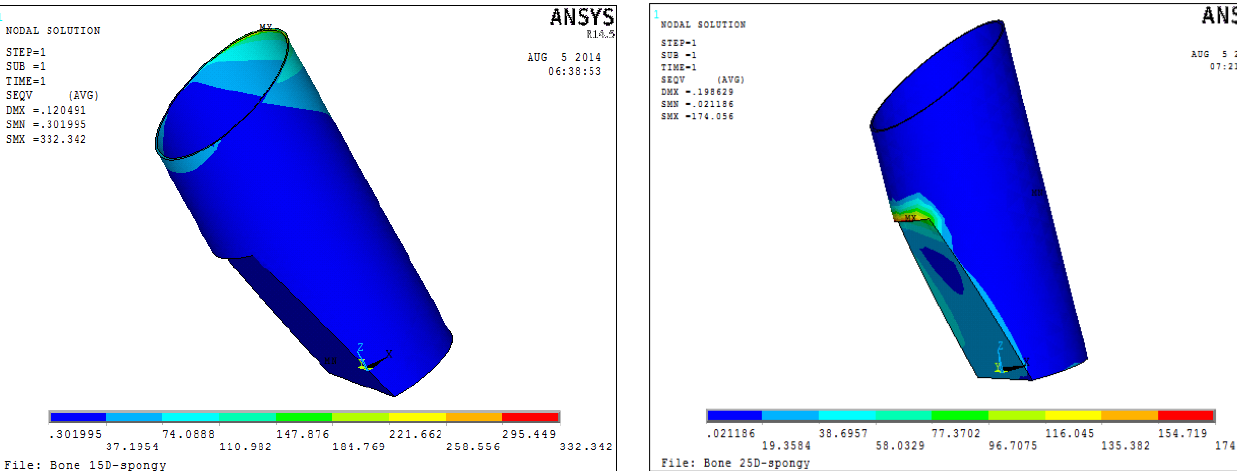
Fig. 7: Cement layer Von Mises stress distribution comparison between (a) 15°, (b) 25° angulated abutment under IPS E-Max CAD crown.